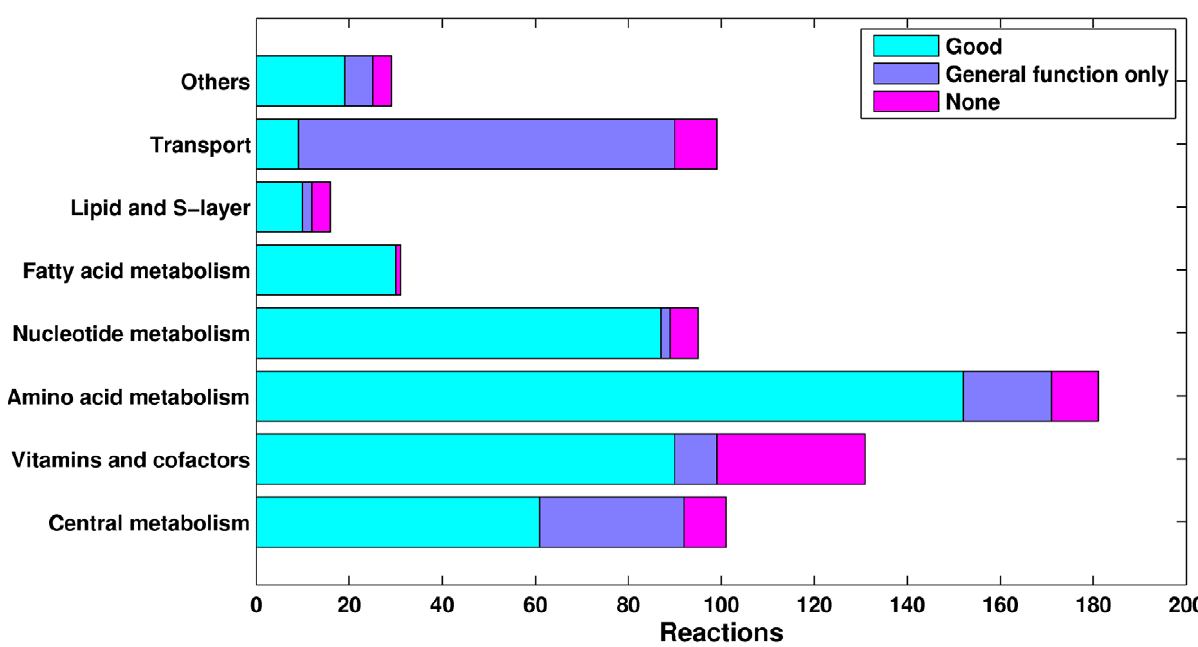
Figure 1. Metabolic network statistics. The reconstructed metabolic network for Natronomonas pharaonis is composed of 683 reactions, covering 654 genes, and 597 metabolites. The graph shows how the reactions are distributed among general functional categories, and also shows the numbers for which: (1) enzyme-coding genes could be reliably assigned; (2) only genes with general functional annotation (i.e., with unclear substrate specificity) could be associated; and (3) no genetic evidence could be found. Reactions with no associated evidence were added to the network in order to fill pathway ‘‘gaps’’. Note that most transport reactions are labeled ‘‘General function only’’. This is because it is generally very hard to assign substrate specificities to transporters using sequence analysis